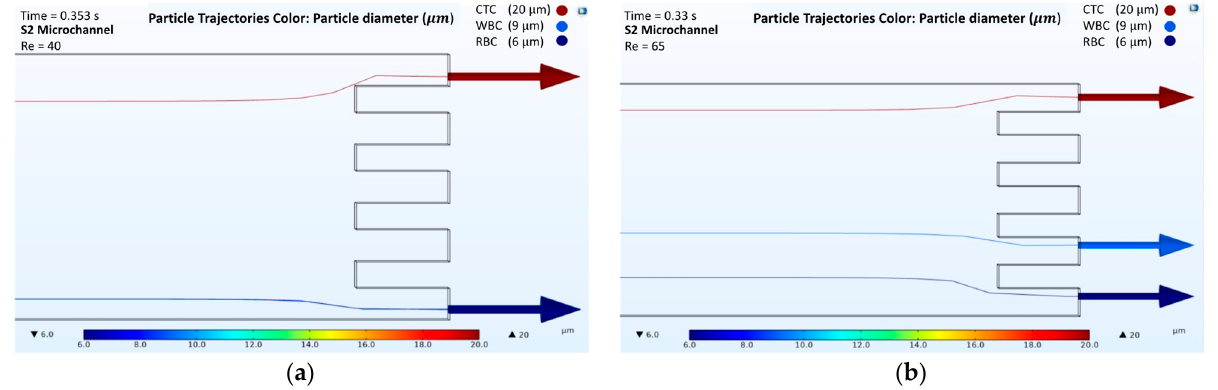
Figure 4. Numerical results of the cell separation study in the S2 microchannel. CTC, WBC, and RBC cells are represented by dark red, light blue, and dark blue colors, respectively: ( a ) Cell distribution at the outlet of the S2 microchannel at a Reynolds number of 40; ( b ) Cell distribution at the outlet of the S2 microchannel at a Reynolds number of 65.